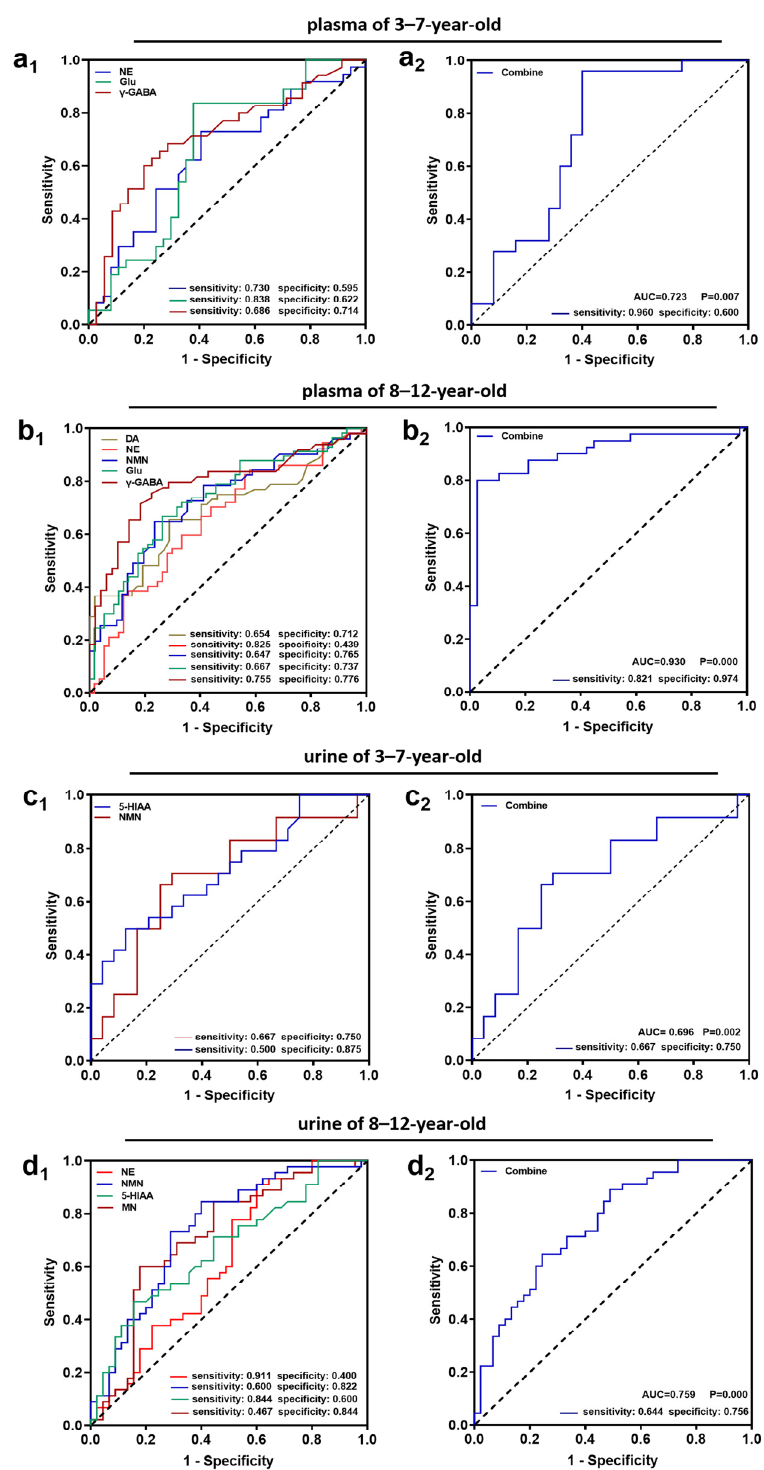
Figure 1. ROC curves of plasma and urine levels of neurotransmitters for predicting TD. ( a 1 – d 1 ) ROC curves of neurotransmitters with areas under the curve (AUCs) greater than 0.5 and significant differences ( p < 0.05). ( a 2 ) ROC curve of the combination of NE, Glu, and γ -GABA levels in plasma from 3–7-year-old children. ( b 2 ) ROC curve of the combination of DA, NE, NMN, Glu, and γ -GABA levels in plasma from 8–12-year-old children. ( c 2 ) ROC curve of the combination of NMN and 5-HIAA levels in urine from 3–7-year-old children. ( d 2 ) ROC curve of the combination of NE, NMN, 5-HIAA, and MN levels in urine from 8–12-year-old children.